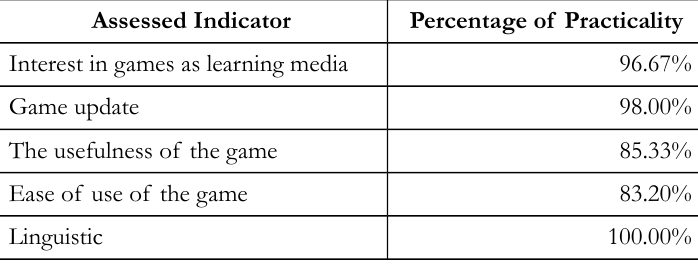
Table 3. Questionnaire response